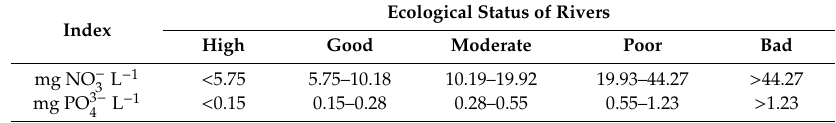
Table 2. Ecological status classification according to the physicochemical quality elements